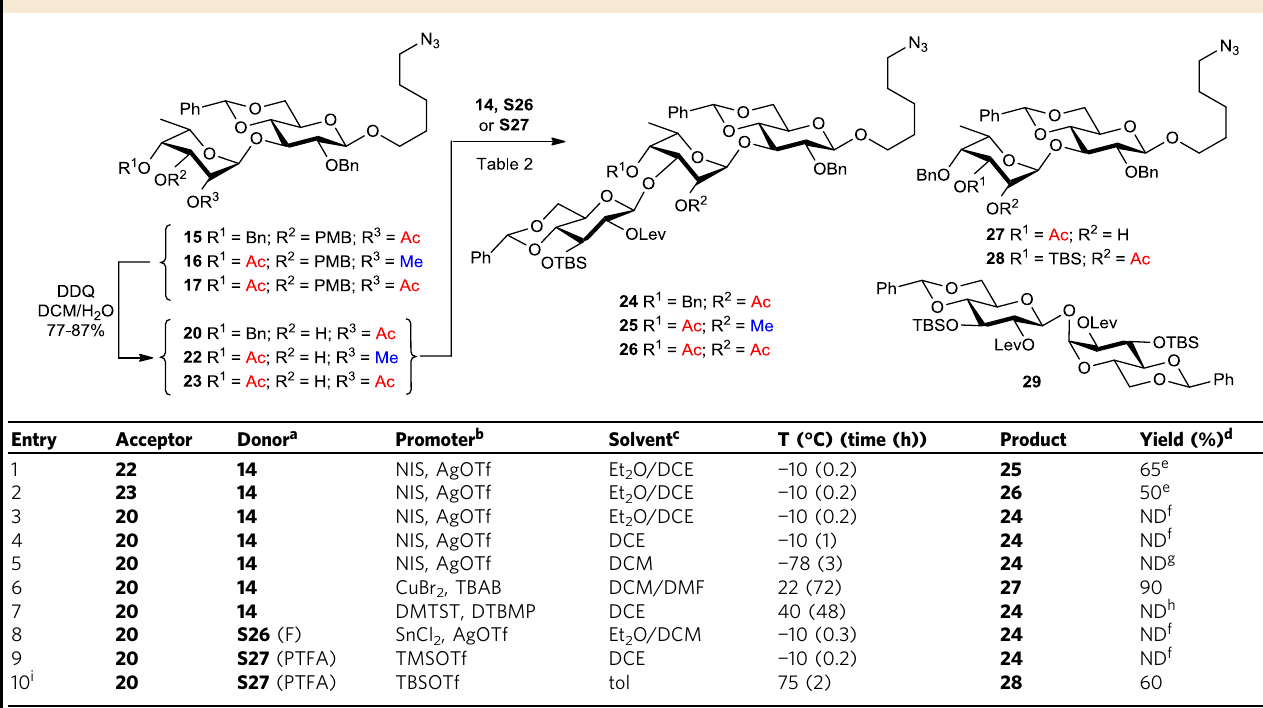
Table 2 Synthesis of protected